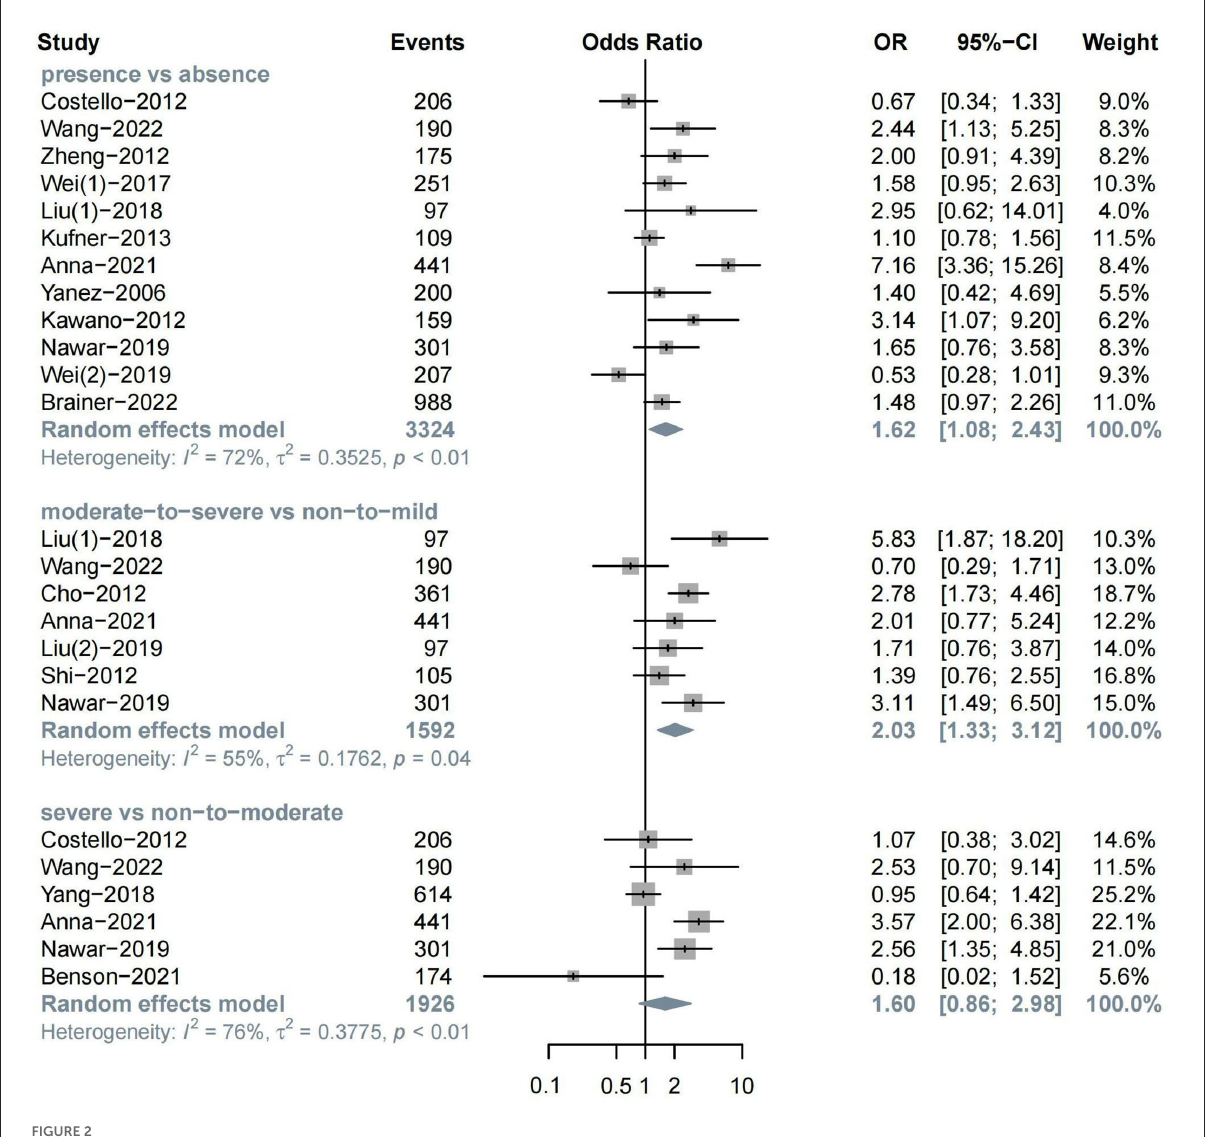
FIGURE2 The severity of WML and the risk of